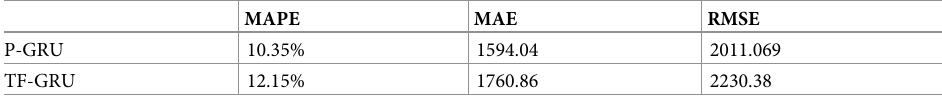
Table 1. Comparison of the results of P-feature and TF-feature in GRU.